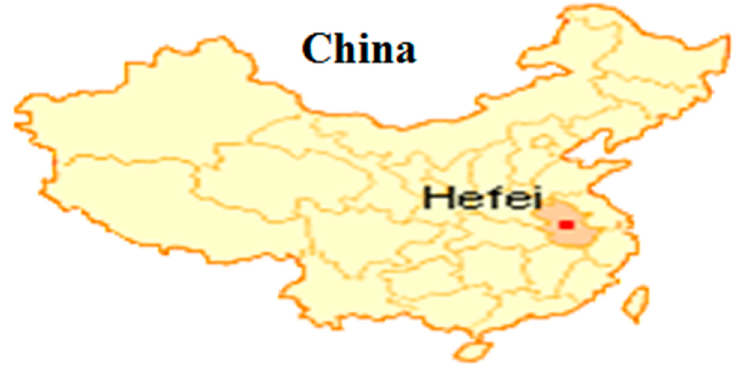
Figure 1. Location of Hefei observation site for multi-axis differential optical absorption spectroscopy (MAX-DOAS) measurements in China.